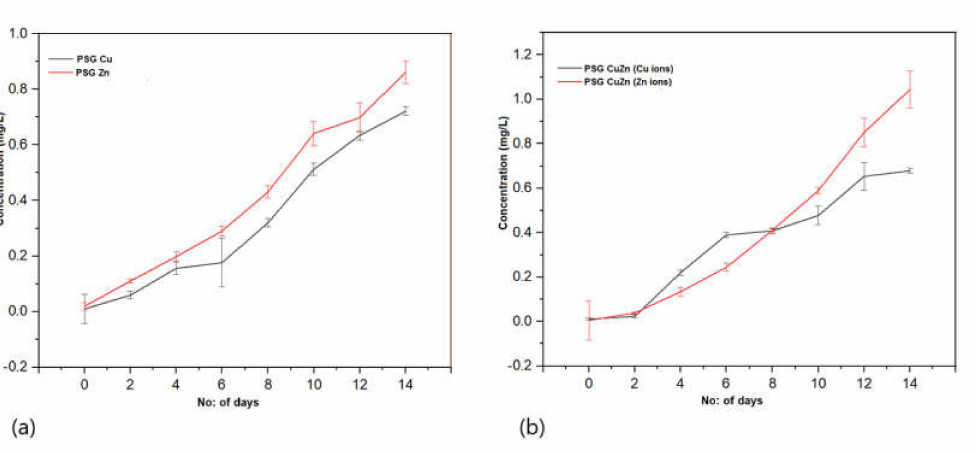
Figure 8. Release profile of Cu +2 and Zn +2 ions from ( a ) PSG-Cu and PSG-Zn films. ( b ) PSG-CuZn film when kept submerged in water for 14 days. The analysis was conducted using a Perkin Elmer Optima 8300